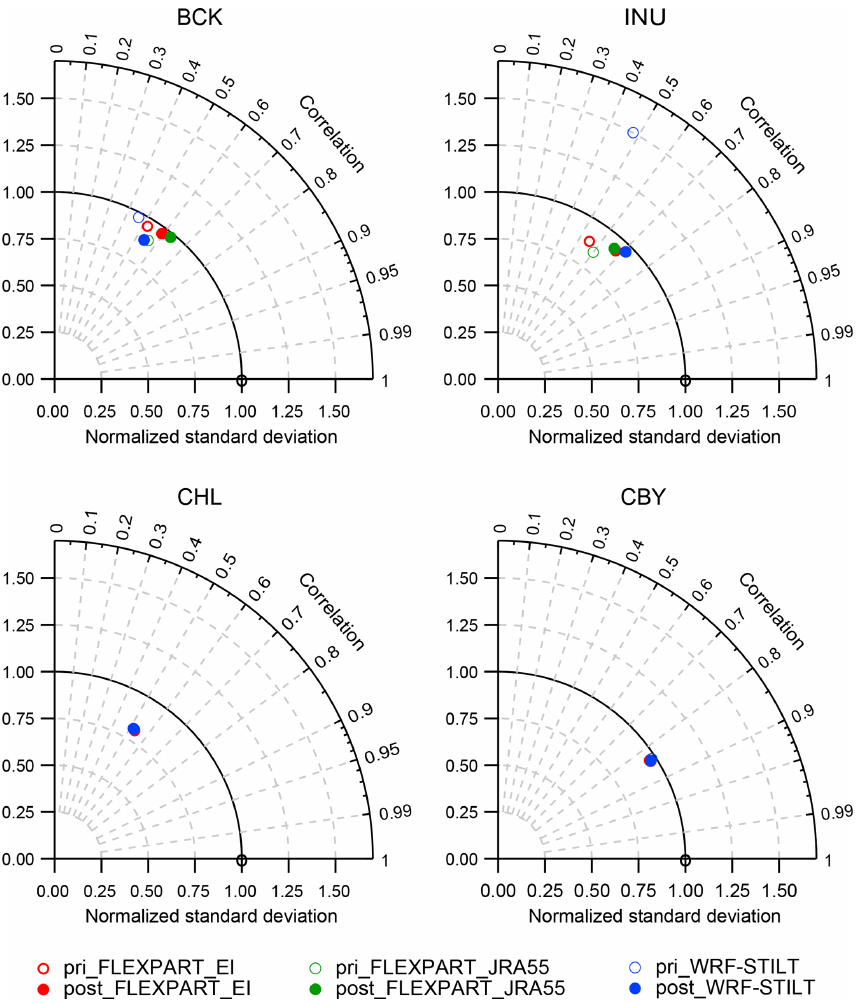
Figure 12. Taylor diagrams for the comparison between the prior (open circles) and posterior (closed circles) mixing ratios by three models: FLEXPART_EI (red), FLEXPART_JRA55 (green), and WRF-STILT (blue), with mask B and prior flux case WetC. The radius is the nor- malized standard deviation (NSD) of modelled mixing ratios against observations. The angle is the correlation coefficient. The values are the means with all observations and modelled mixing ratios for each